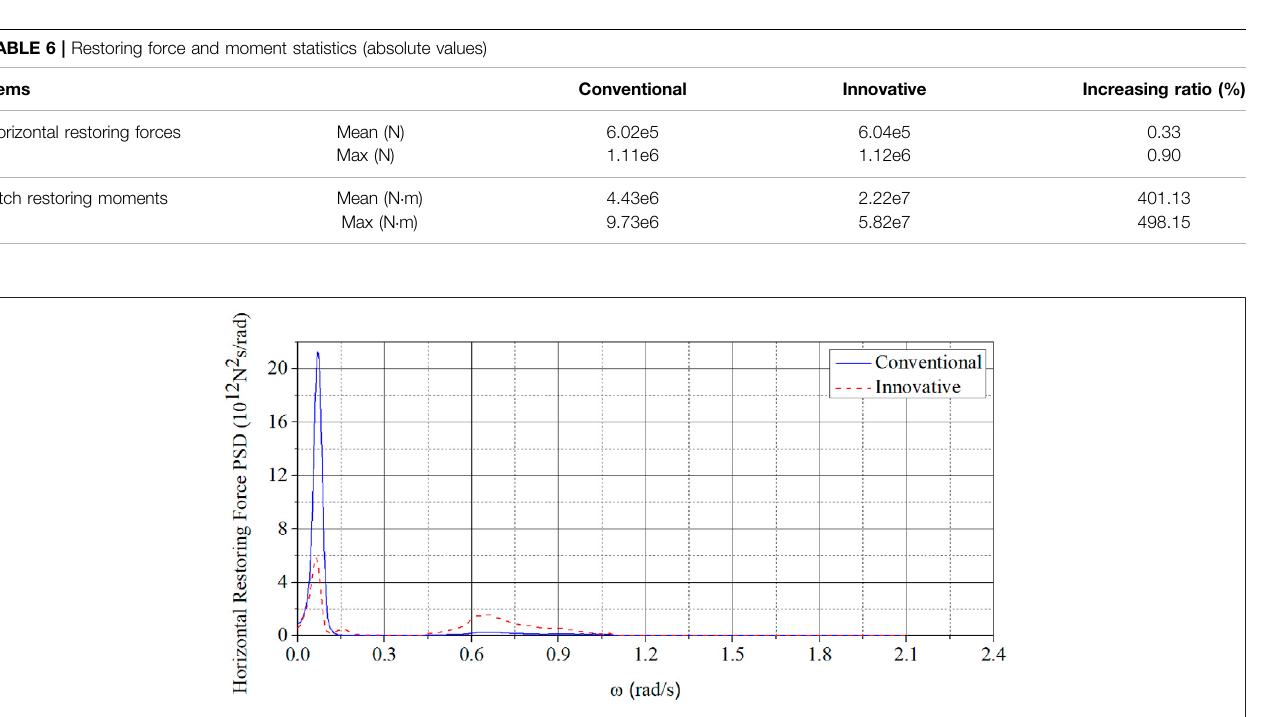
FIGURE 13 | PSD of horizontal restoring